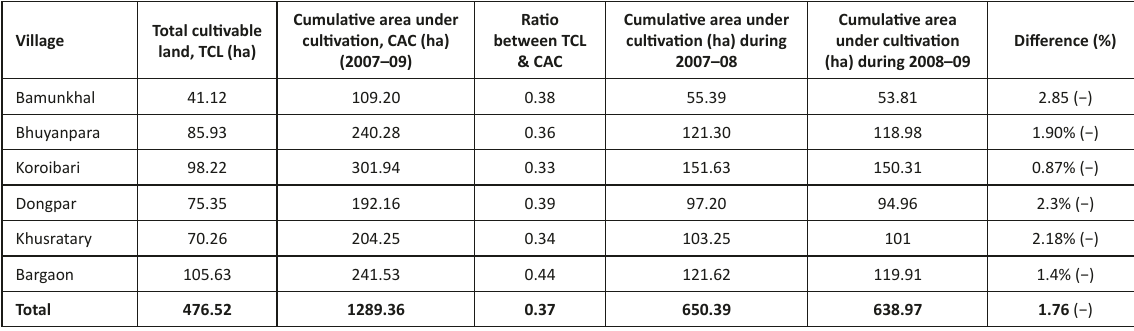
Table 1. Total cultivable land (TCL) and cumulative area under cultivation (CAC) recorded during study period. Total cultivable Village land, TCL (ha)